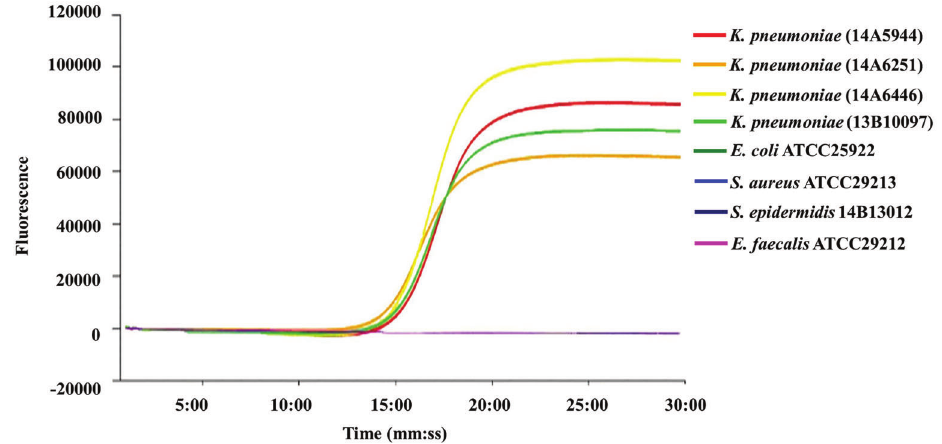
Figure 2. The ampli fi cation curve results of loop-mediated isothermal ampli fi cation (LAMP) speci fi city reaction. Speci fi city of the LAMP assay for detecting the target gene of ureR_1 by Genie s II. Genomic DNA of K. pneumoniae was used as the template for the LAMP test. All experiments were repeated twice.